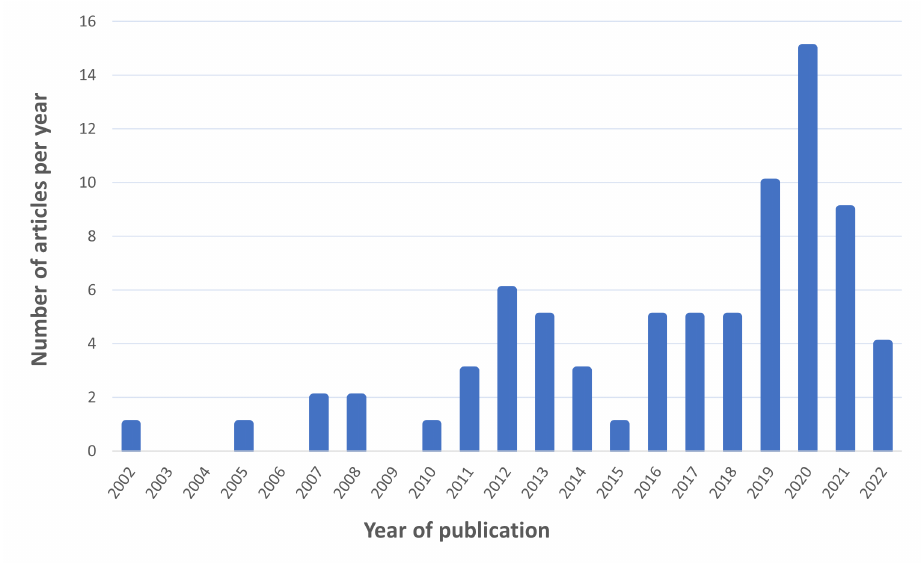
Figure 5. The number of included articles published per